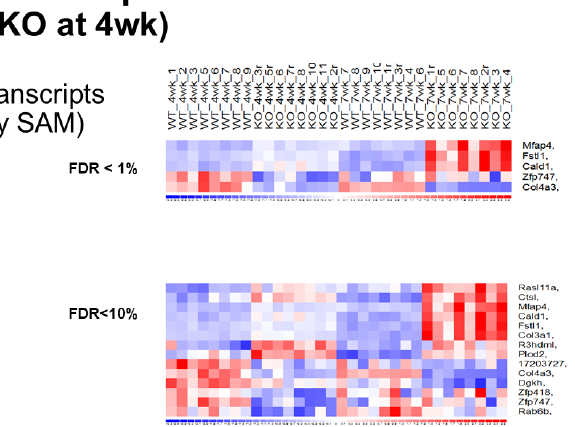
Figure 4. Differential Gene Expression in WT vs. KO mice at 4 Weeks of Age. Explanation of the statistical parameters used to identify the 5 differently expressed genes at 4 weeks of age in WT vs. KO mice.